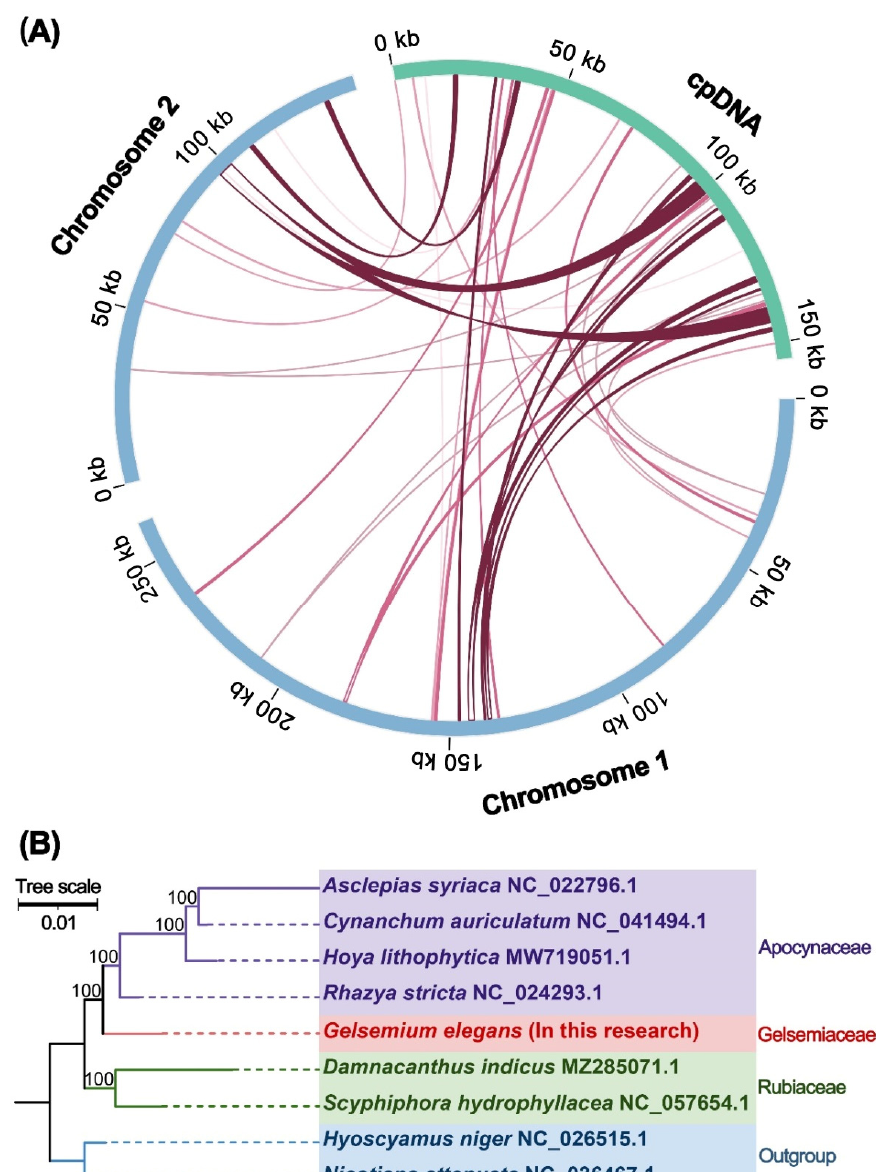
Figure 6. Homologous fragments and phylogenetic analysis of G. elegans . ( A ) The blue arcs represent the mitochondrial genome, the green arcs represent the chloroplast genome, and the red lines between the arcs correspond to homologous genomic fragments. ( B ) The evolutionary relationship between G. elegans and homologous species.